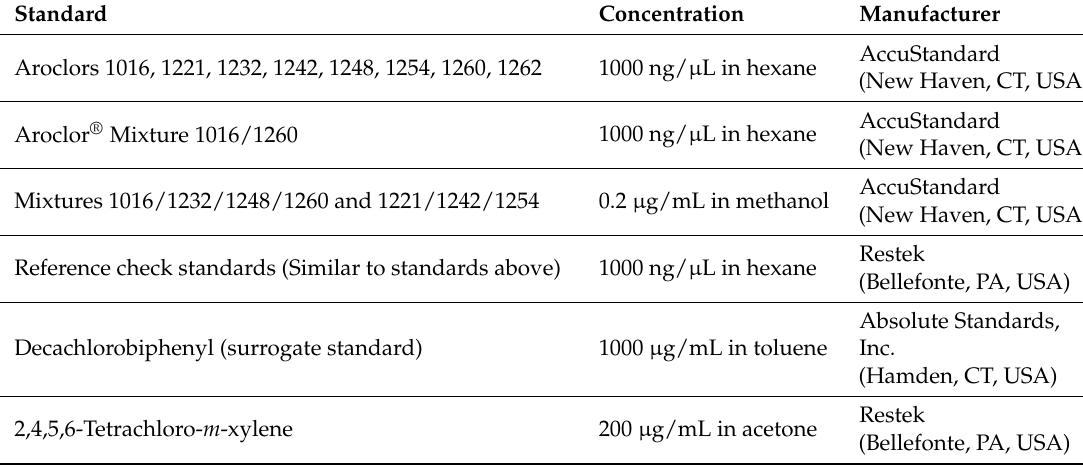
Table 1. PCB Aroclor ® Standards.